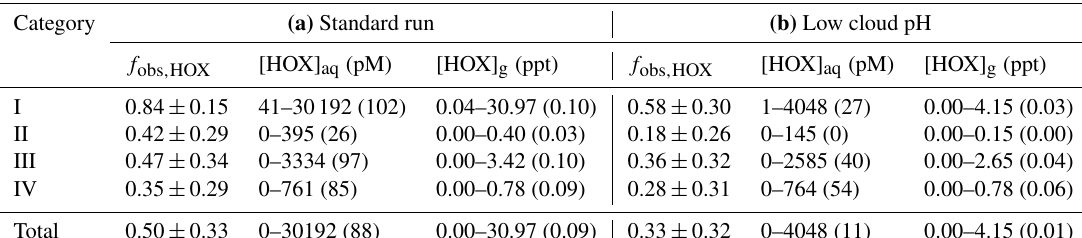
Table 4. f obs , HOX , [HOX] aq and [HOX] g calculated using the model results from (a) the standard run and (b) low cloud pH run, respectively. The mean and standard deviation are shown for f obs , HOX . The range and median value are shown for [HOX] aq and [HOX] g .